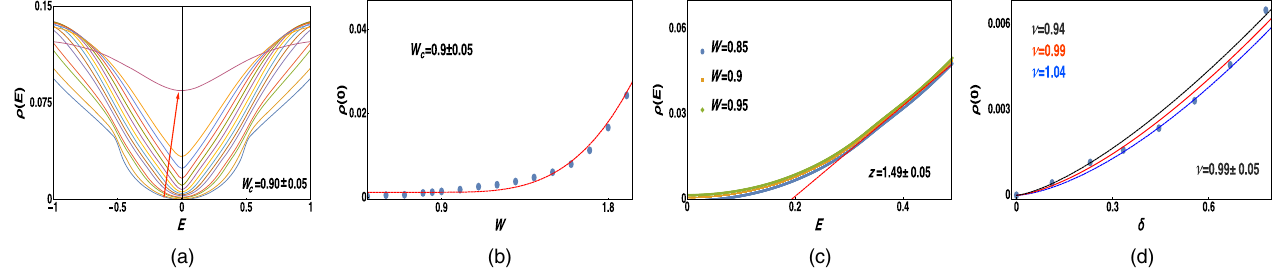
FIG. 23. Numerical analysis of average DOS in the presence of correlated potential disorder [see Appendix F and Eq. (F1)]. Scaling of (a) average DOS [ ϱ ð E Þ ] with increasing strength of disorder (in the direction of the red arrow), (b) average DOS at zero energy [ ϱ ð 0 Þ ] 0 . 90 (cid:2) 0 . 05 , (c) average DOS [ ϱ ð E Þ ] around critical with increasing disorder in the system, yielding critical disorder strength W c ¼ disorder W ¼ 0 . 85 (blue), 0.90 (yellow), and 0.95 (green) [fitting ϱ ð E Þ with j E j d=z − 1 , we obtain z ¼ 1 . 49 (cid:2) 0 . 05 ], (d) ϱ ð 0 Þ with the 0 . 90 and z ¼ 1 . 49 . For discussion on reduced distance from the WSM-metal critical point ( δ ), yielding ν ¼ 0 . 99 (cid:2) 0 . 05 with W c ¼ error analysis in the determination of ν , see Appendixes E and F, as well as Table IV (the second to the last